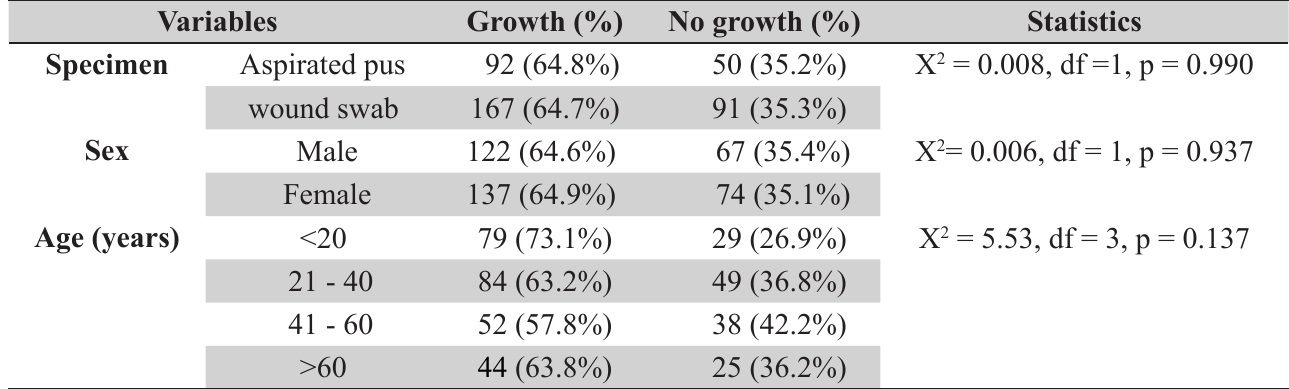
Table 1. Type of specimen, sex and age wise distribution of wound infection (N =